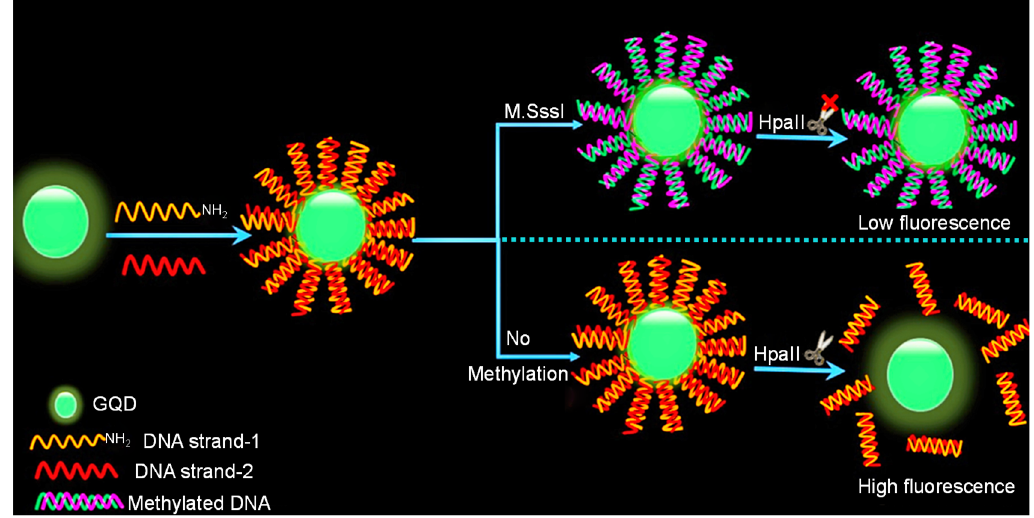
Figure 2. Schematic representation of a fluorescent assay for DNA methyltransferase activity [95]. A label-free GQD-based ratiometric fluorescence assay was proposed for detecting the DNA by merging the cutting endonuclease enzyme supported with the hemin DNAzyme / G-quadruplex bio-catalysis via the target recycling as well as a cascade signal amplification strategy [96]. In the study, o-phenylenediamine (OPD) was chosen as a hemin DNAzyme / G-quadruplex substrate, where 2,3-diaminophenazine (DAP), i.e., the oxidized product, could quench the fluorescence of GQDs (~460 nm), coupled with a fresh emission of DAP (~564 nm). Such a ratiometric signal (i.e., I 564 / I 460 ) could sensitively and specifically determine target DNA, with an LOD of 30